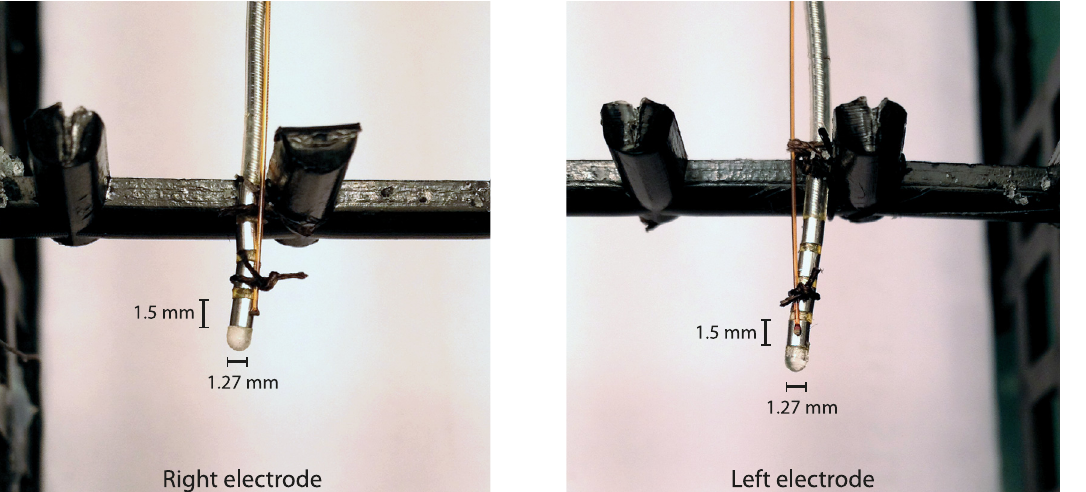
Fig 3. The fibre-optic temperature sensors positioned at the distal electrode contacts. The fine golden leads are the temperature probe optical fibres, whereas the grey leads with 4 visible metal contacts are the DBS electrode leads. Suture silk was used to ensure that the thermometer probes were in close thermal contact with the distal electrode contact surfaces, previously demonstrated to be the sites of greatest MRI-induced